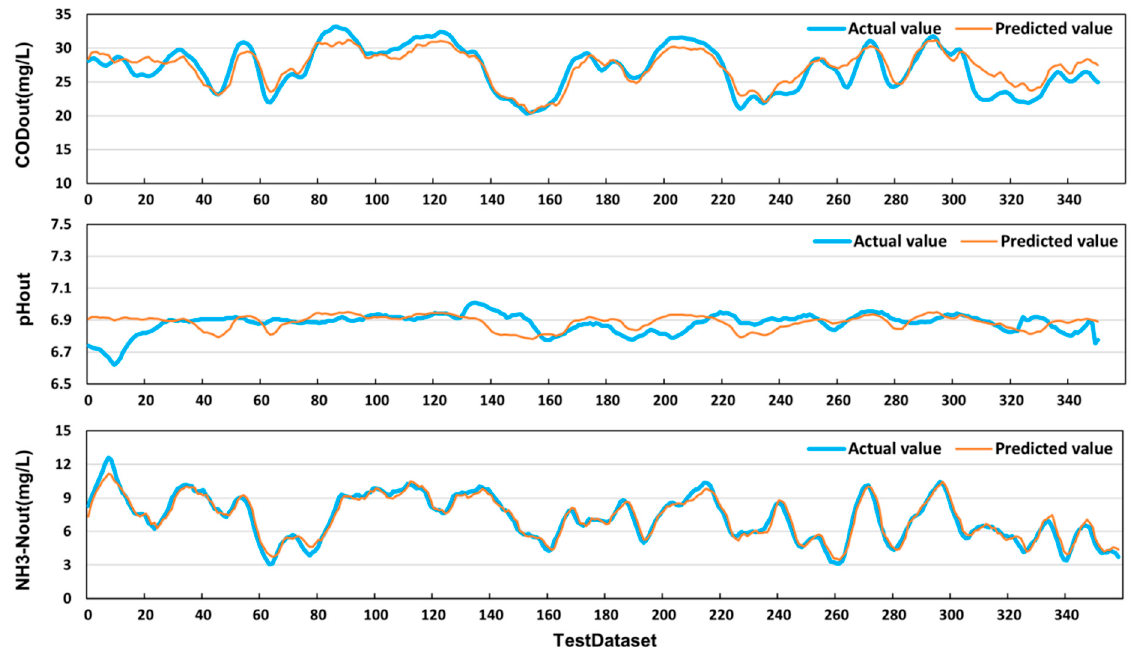
Figure 6. Comparison of the model-predicted and actual values for the untrained testing set with 351 samples at a prediction interval Δ t : 9 h.